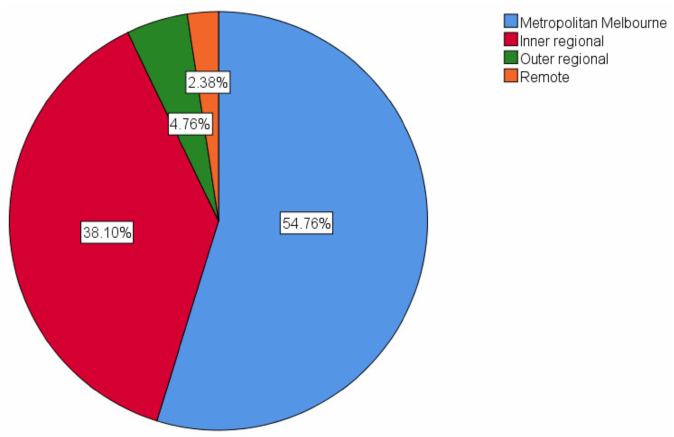
Figure 2. Location of the health service at which the survey responder is based classified according to the Australian Government’s workforce classification system